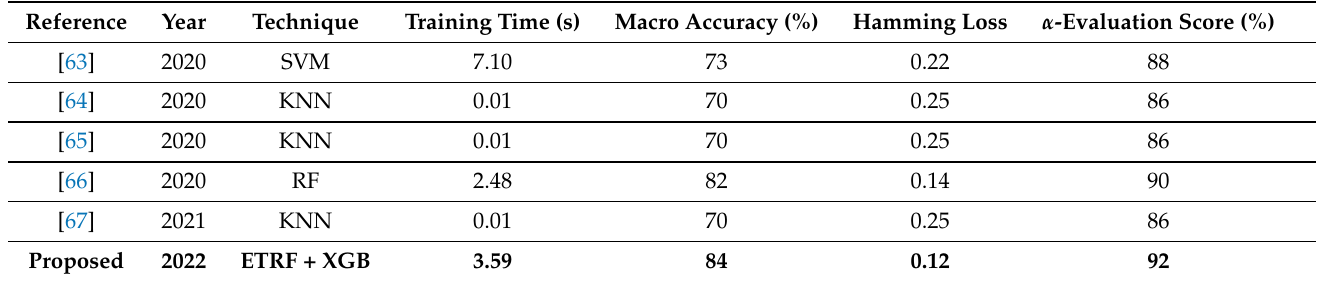
Table 15. Comparative analysis of proposed approach with state-of-the-art